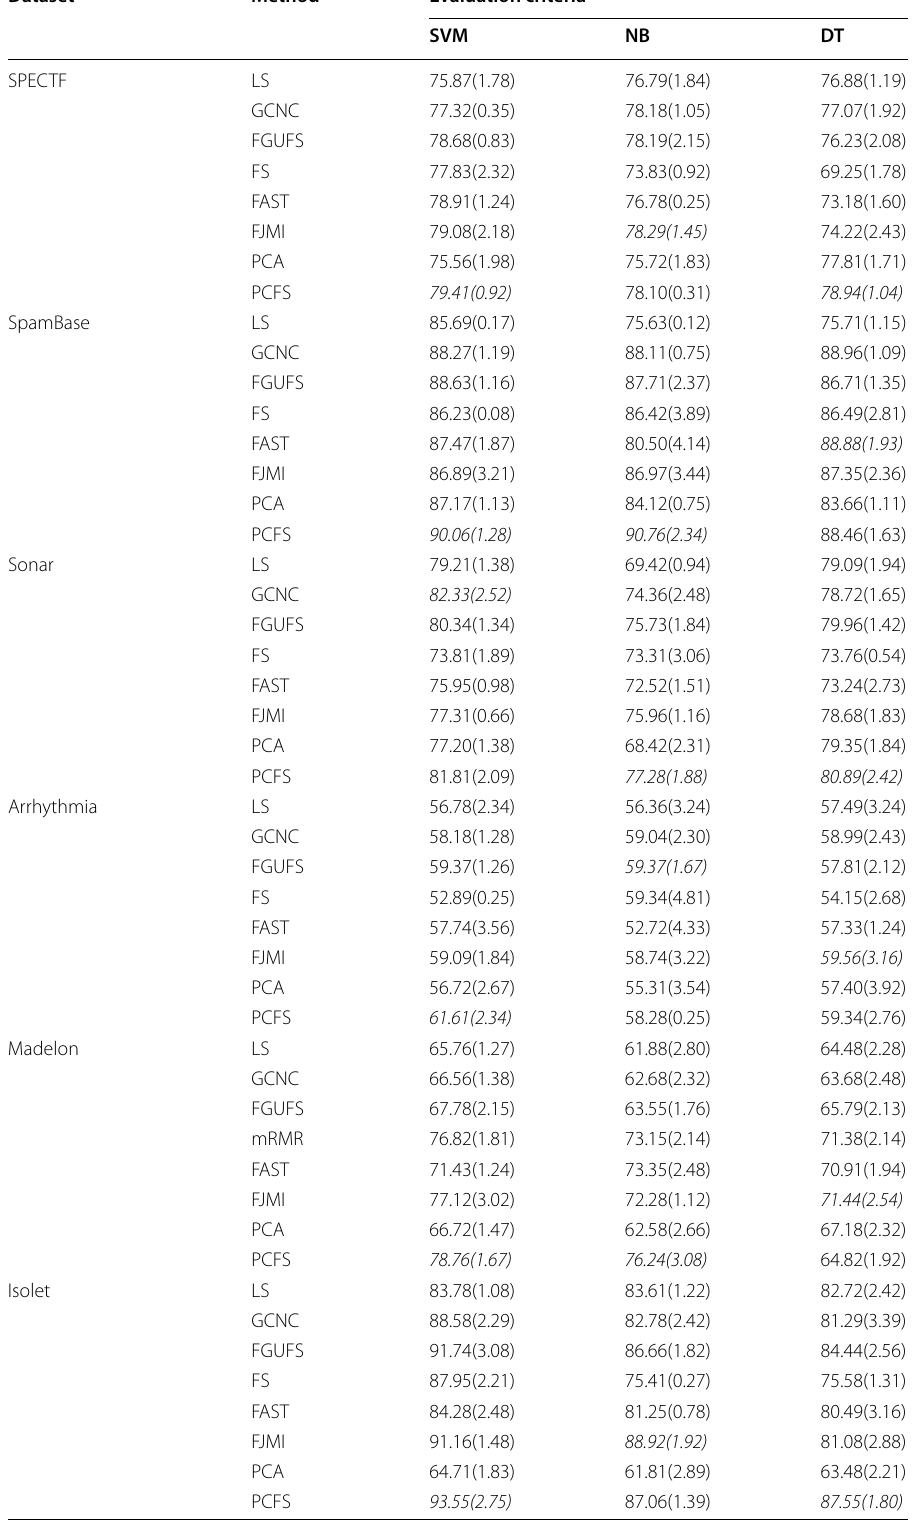
Table 2 Performance comparison of different feature selection methods on eight datasets